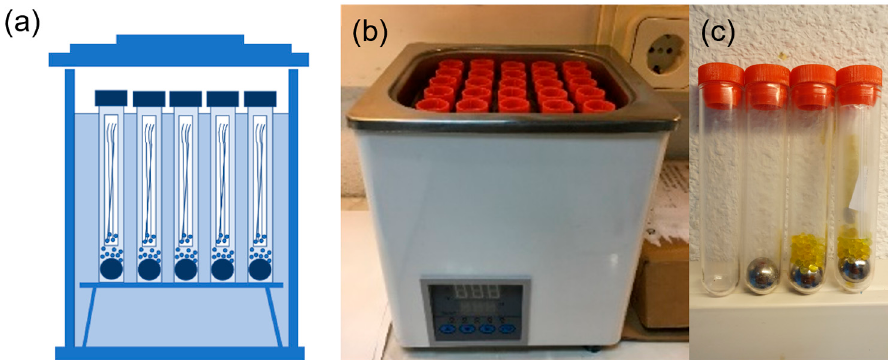
Figure 2. Ageing device. ( a ) Scheme of the ageing device; ( b ) actual picture of the ageing device with 25 test tubes in a 5-by-5 grid, with the middle one used for measuring the temperature; ( c ) preparation of PP test tubes, left to right: PP tube, with a ball of steel, with desiccant, with the samples inside a zip bag with more desiccant inside.